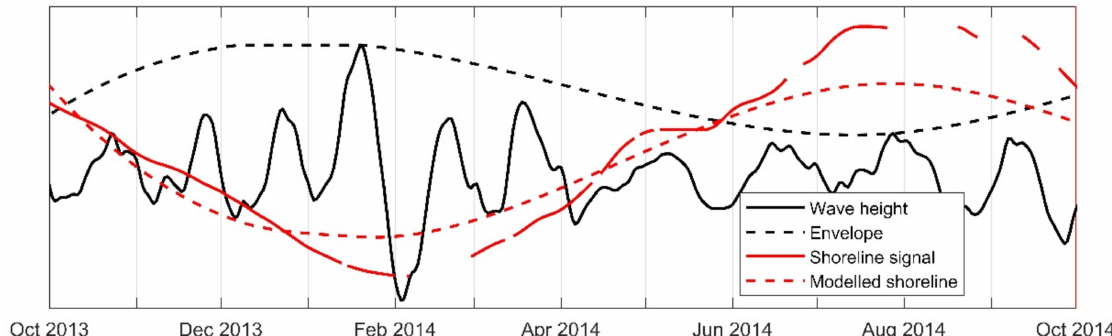
Figure 3. The upscaling approach: modelling the persistent effect of extreme forcing events on the longer-term state of the beach. The effect of the small timescale wave height timeseries (black-solid) on a larger shoreline position timescale (red-solid) is modelled using the envelope of the wave height timeseries (black-dashed), which creates the timescale link. A similar approach is followed for the wave period. The resulting modelled shoreline is given by the dashed red